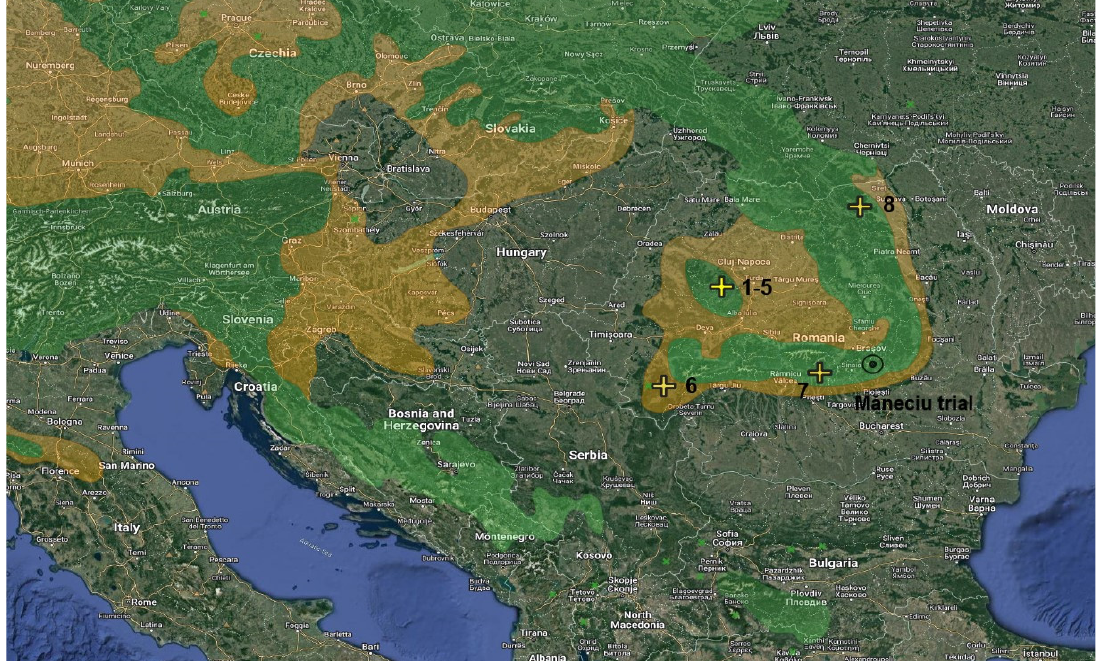
Figure 1. Natural (green) and artificial (yellow) distribution map of Norway spruce [54], origins of pendula provenances, and the location of the M ă neciu trial.